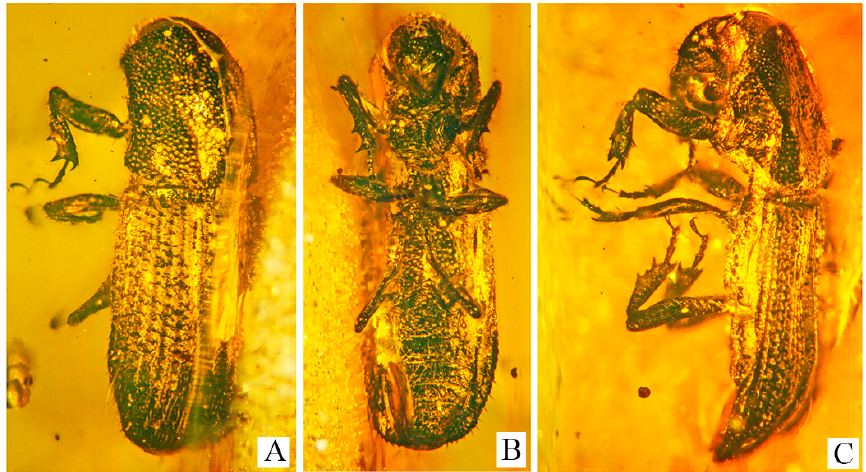
Figure 1. Gongyloceria dominicana sp. nov., holotype—Dominican amber: ( A ) dorsal view; ( B ) ventral view; ( C ) lateral view.